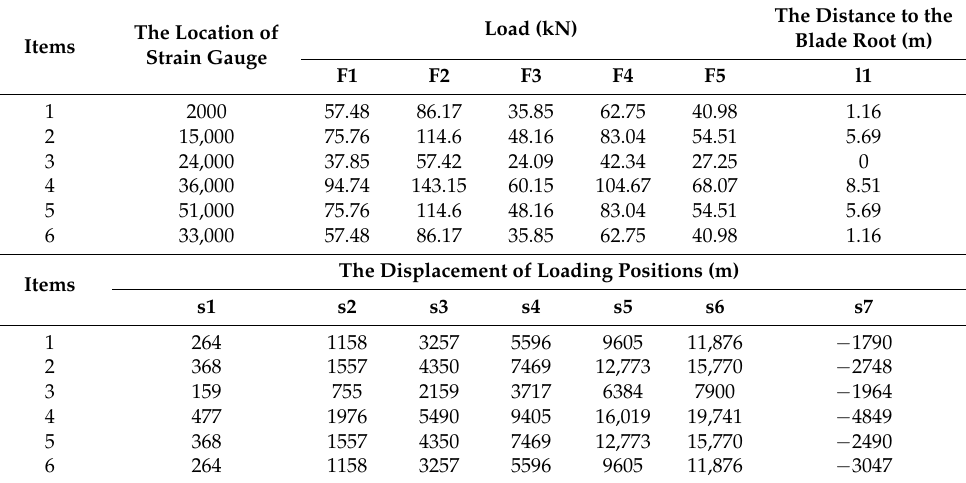
Table 4. The test samples of the